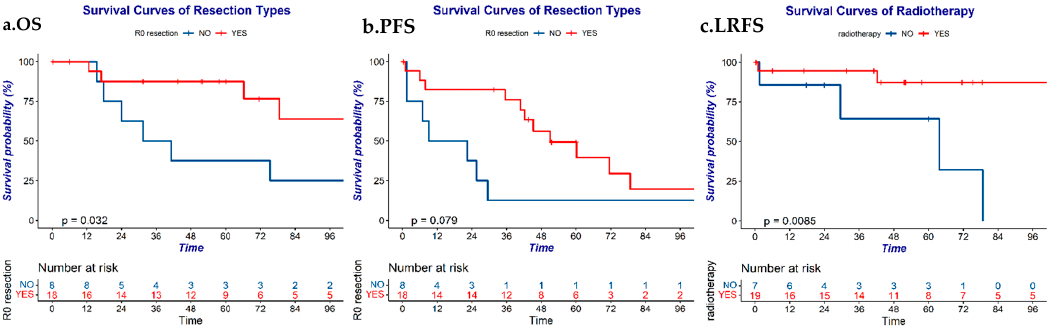
Figure 3. ( a , b ) The OS and PFS of lesions with or without complete resection. ( c ) The LRFS of lesions with or without radiotherapy. Abbreviation: OS: overall survival; PFS: progression-free survival; LRFS: local-regional relapse free survival.